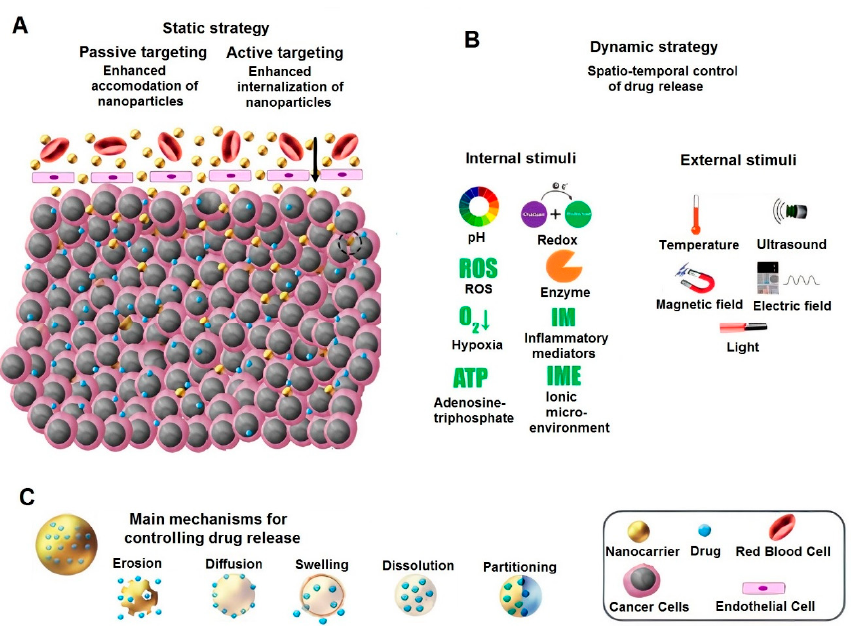
Figure 3. A schematic showing different approaches toward drug delivery for cancer therapy—static ( A ), dynamic ( B ), and main mechanism for controlling drug release ( C ). Reprinted from [49] with permission from Elsevier.